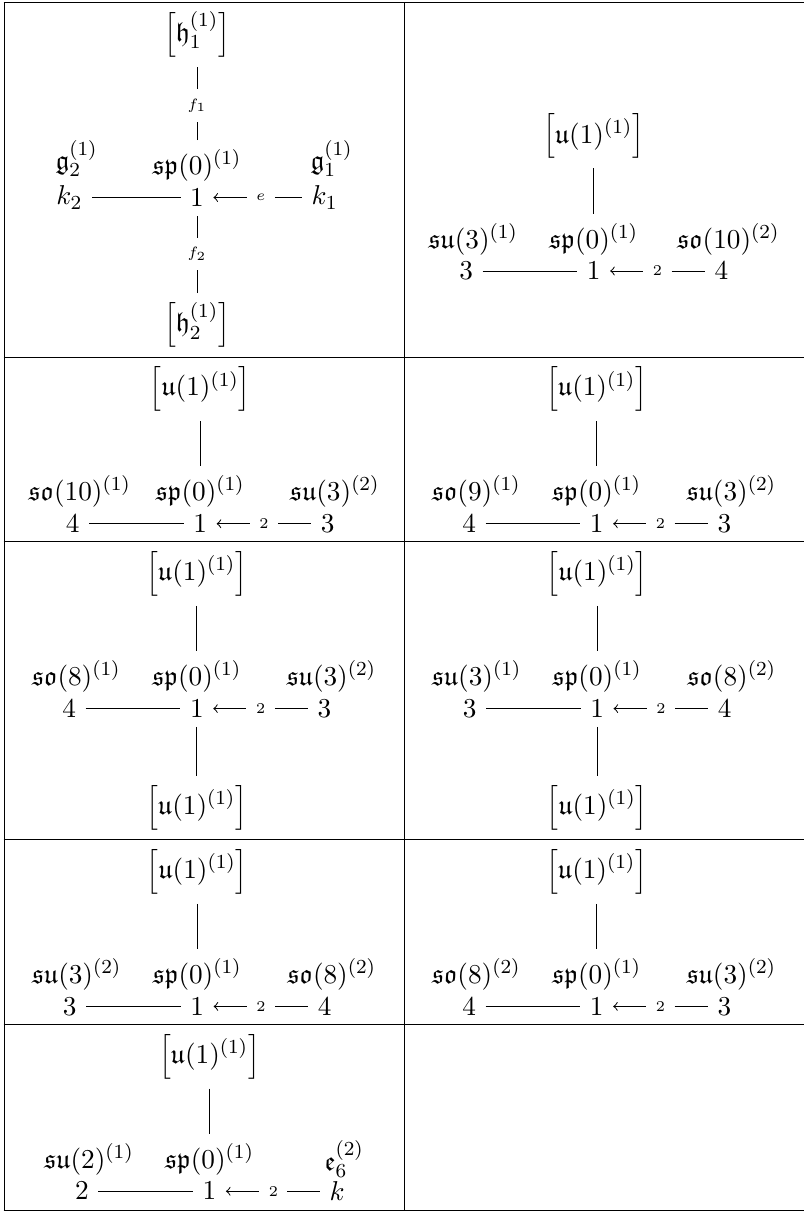
Table 12 . Continued from table 11: possible localized flavor symmetries for nodes with a trivial gauge algebra having incoming directed edges. See text for explanation of first entry in the